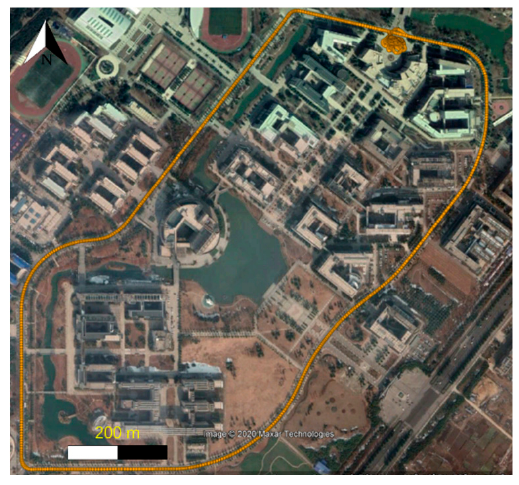
Figure 4. The trajectory projected in Google Earth.